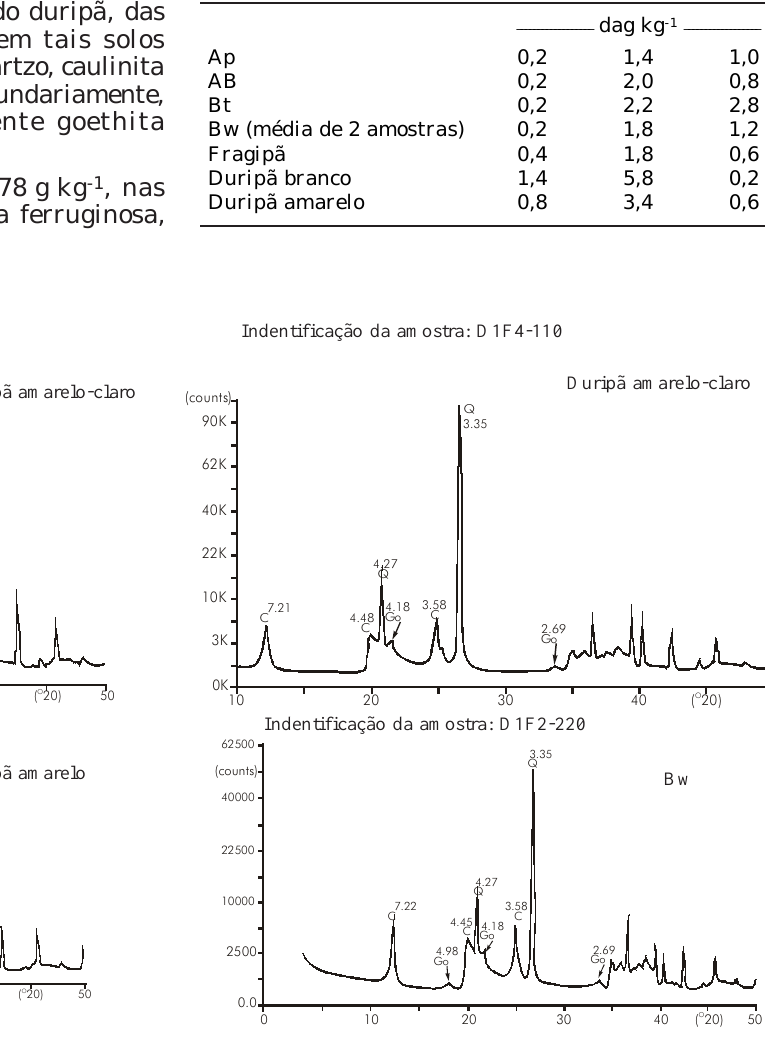
Figura 7. Difratogramas de raio-X referentes aos horizontes da D1 e